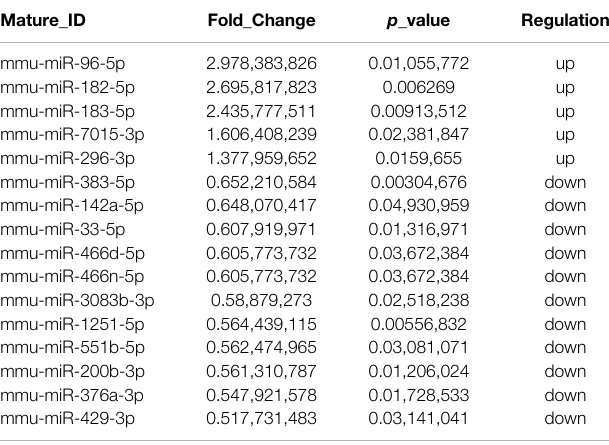
TABLE 3| Differentiallyexpressed miRNAsbetweenTBIand XFZYD-treated mice in hippocampus tissue. Mature_ID